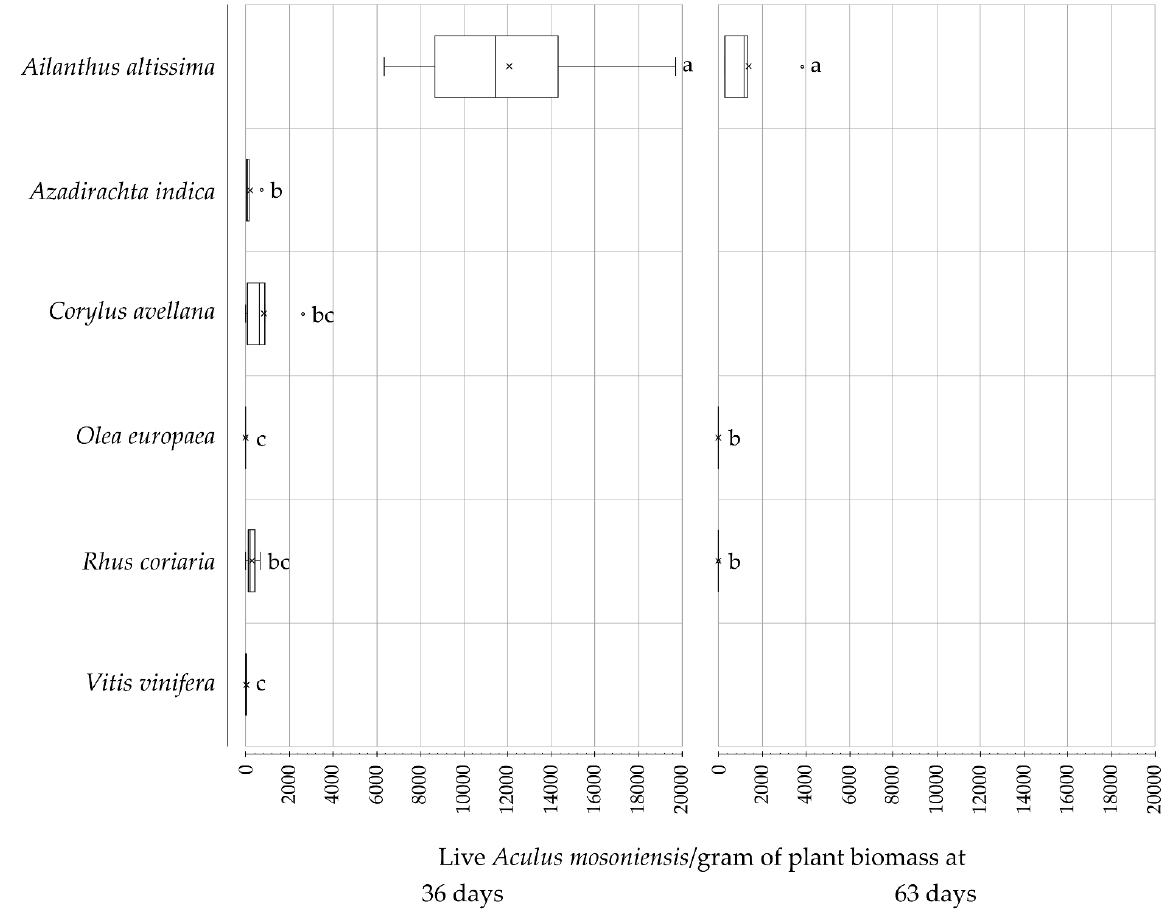
Figure 3. Number of live Aculus mosoniensis per gram of plant biomass collected from the plant species tested at 36 and 63 days post-inoculation, respectively, in the field experiment performed 2020. The boxes represent the first to third quartile range with the median indicated by a line across the box, and the mean by crosses. Outliers are indicated by empty dot. Bars flanked by different letters differ significantly at p = 0.05.